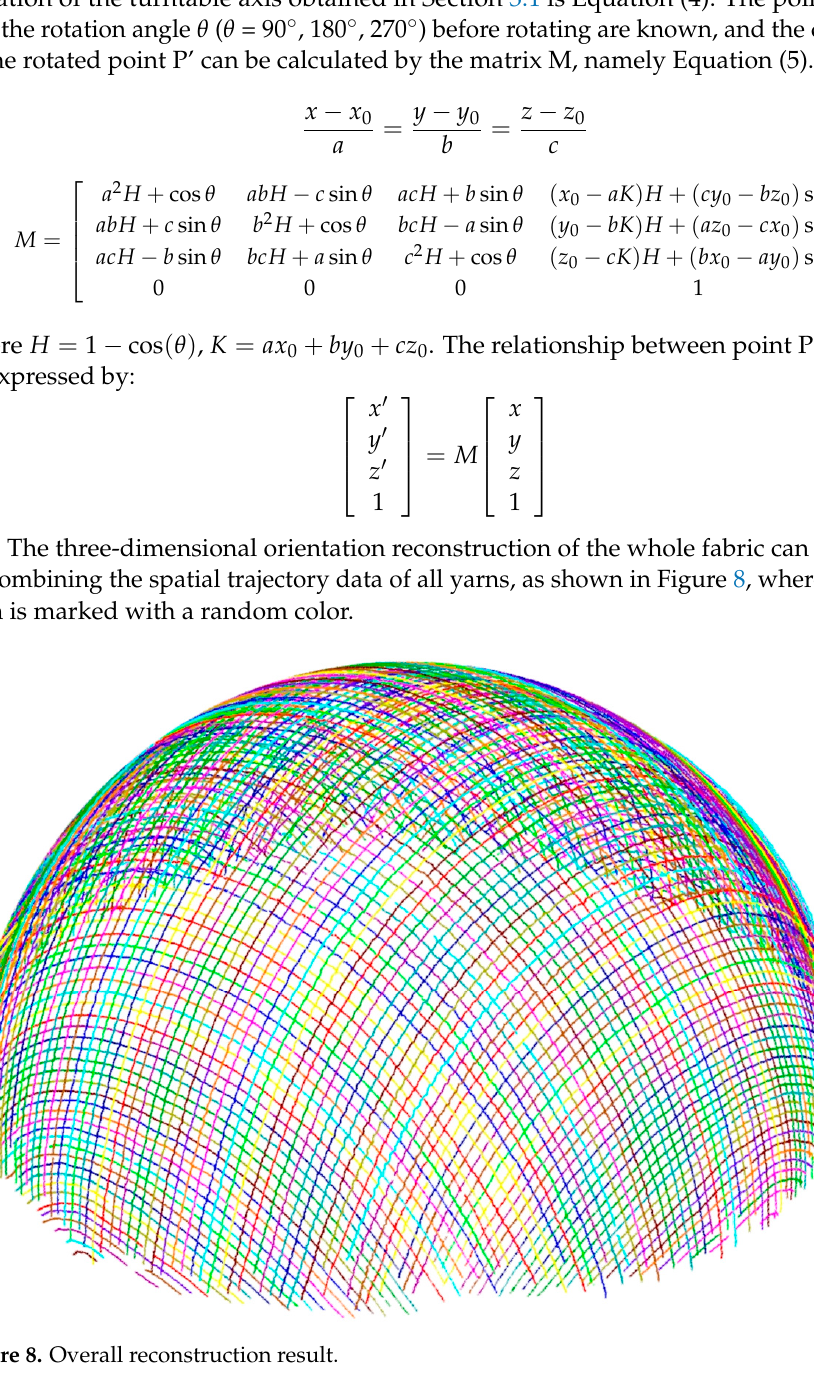
Figure 9. Local defects caused by mechanical cutting.